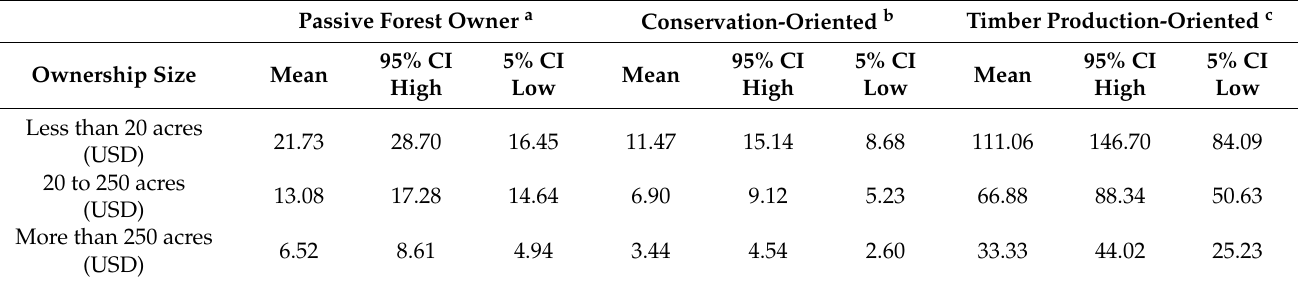
Table 4. Mean willingness to accept payment for carbon contracts across different forest owner types, estimated using benefit transfer techniques and 13 valuation studies.